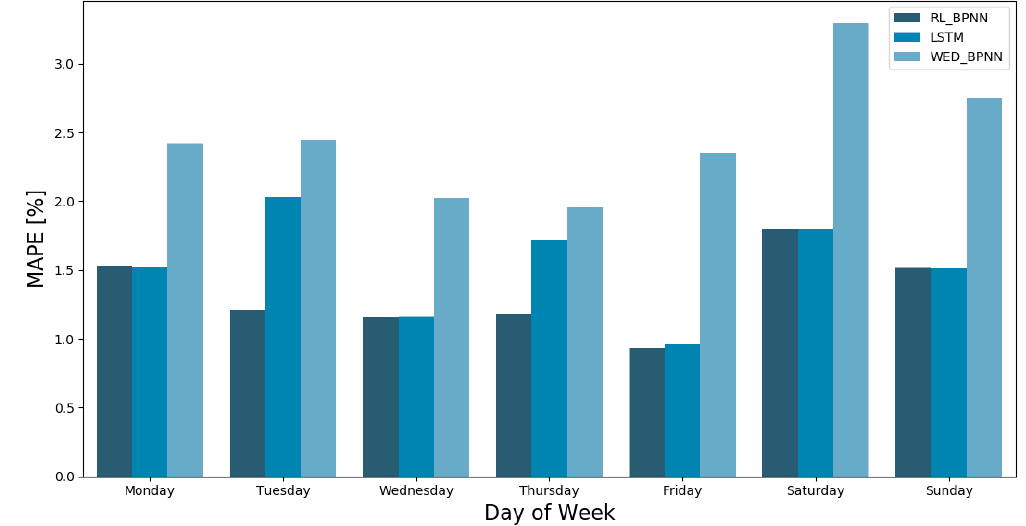
Figure 13. MAPE of the models by day of week.